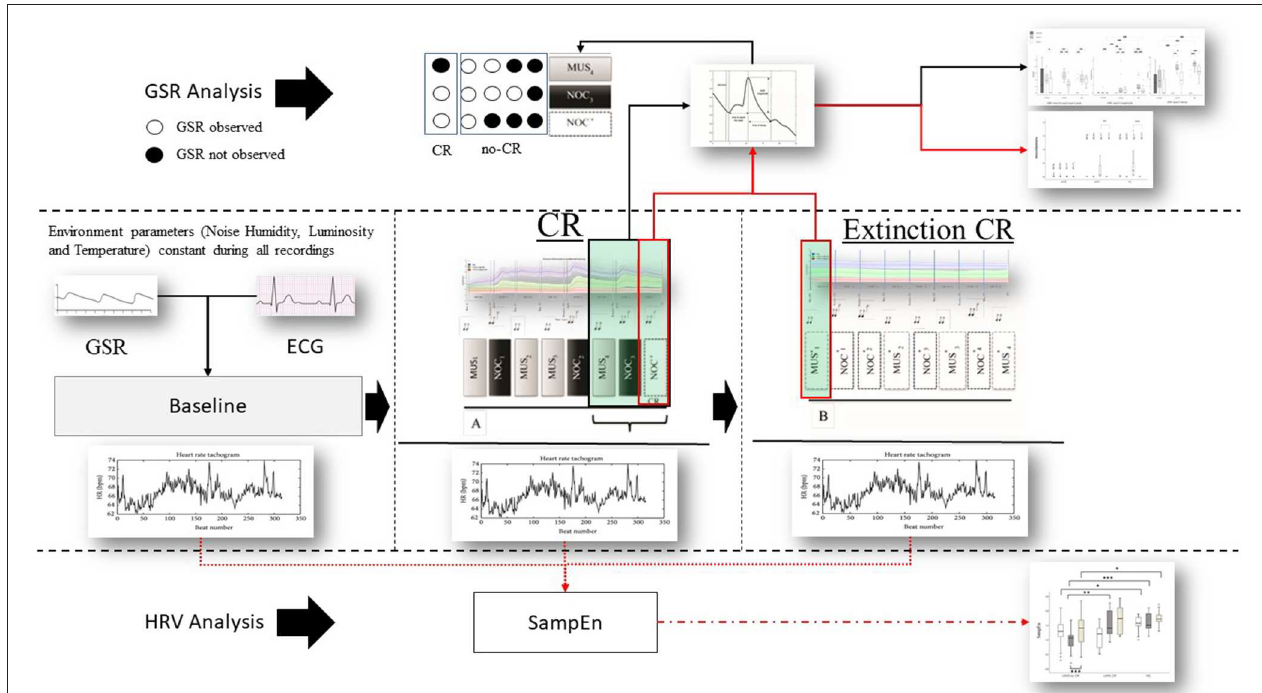
FIGURE 2 | Protocol and data analysis: in the central line of the figure (between dashed lines) the entire sequence of the protocol (baseline, sequence A to test the conditional response (CR), and sequence B to test the extinction of the CR). From each sequence Galvanic Skin Response (GSR) and Electrocardiogram (ECG) were extracted. From the ECG the Inter-Beats Interval (distance between peak to peak of RR ECG signal) was extracted (Bottom the figure—HRV analysis) and Sample Entropy (SampEn) analyzed, then compared between and within groups. GSR was observed in baseline to exclude artifact movements. GRS analysis (above) was performed considering peak magnitude, time to reach the peak, and decay of the GSR signal in the last three phases of the sequence A (black box and black line MUS4, NOC3, and NOC*). It was considered the CR only if the GSR was present in NOC3 and NOC* (circle white filled). Finally, CR’s (red box) extinction was observed in the sequence B. Similarly, for the SampEn, the GSR components (magnitude, time to reach the peak, and decay) were compared between and within groups (black line) and the extinction was compared for wave peak magnitude (red